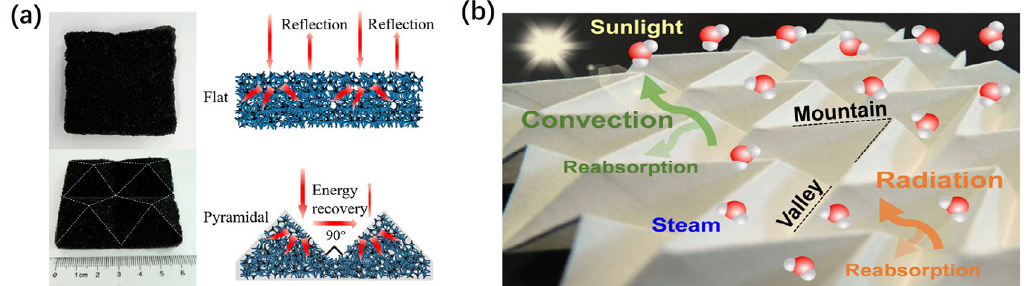
Figure 7 (a) The GE/PPUS-based evaporator with pyramidal shape for solar-driven evaporation. Reproduced with permission from Ref. [107], © American Chemical Society 2019. (b) 3D origami-based solar steam generator. Reproduced with permission from Ref. [64], © American Chemical Society